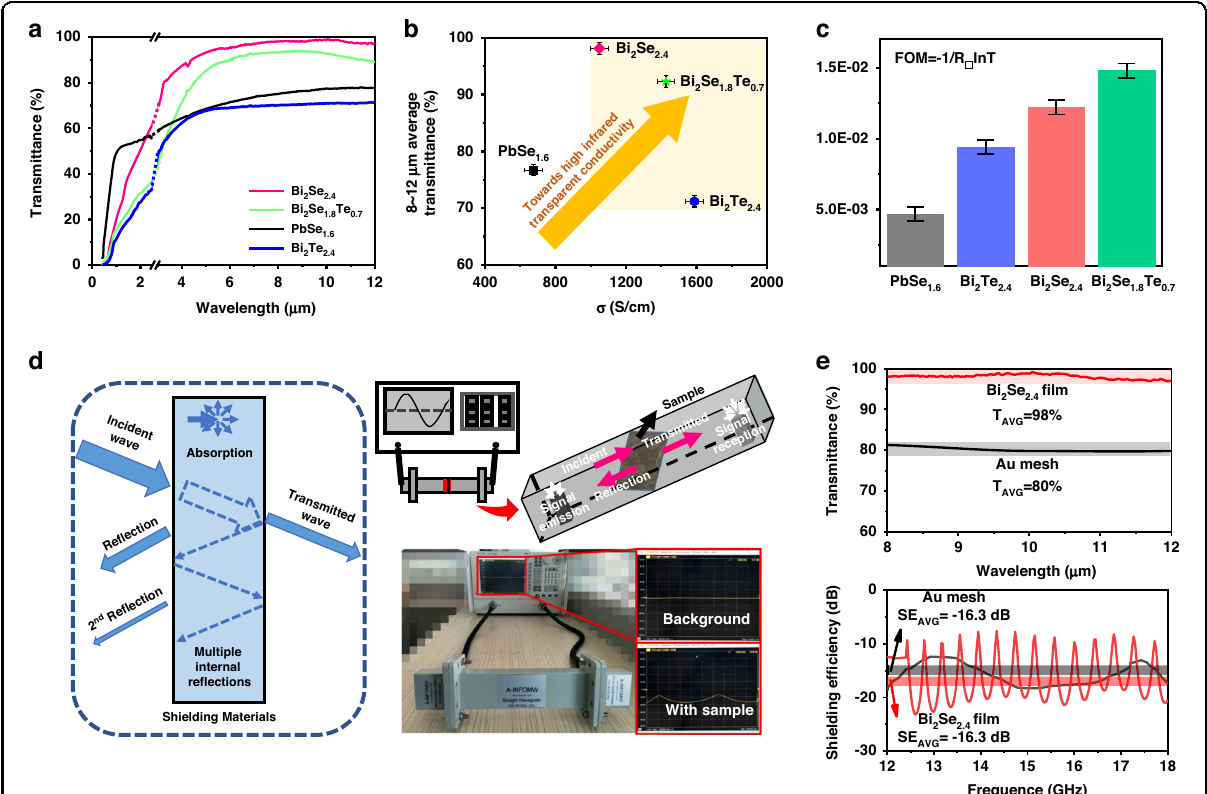
Fig. 5 Far-infrared transparent conductive properties and electromagnetic shielding ef fi ciency of high- ε opt materials. a Far-infrared transmission spectra, b conductivity, average transmittance, and c FOM for r-Bi 2 Se 2.4 , r-Bi 2 Te 2.4 , r-Bi 2 Se 1.8 Te 0.7 , r-PbSe 1.6 . We have removed the 2.5 – 3 μ m data due to the presence of instrument-generated miscellaneous peaks and connected the data with dashed lines for aesthetic reasons. d Diagram of electromagnetic shielding principle (left) and self-built electromagnetic shielding ef fi ciency test system (right). e Far-infrared transmittance and electromagnetic shielding ef fi ciency for Bi 2 Se 2.4 fi lm and Au